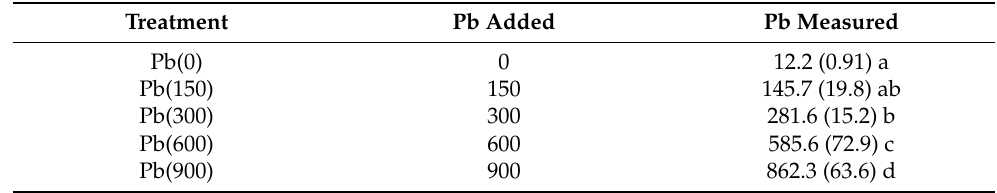
Table 1. Added and measured Pb with aqua regia (pseudo-total) (units in mg Pb kg − 1 soil). Standard deviations of measured Pb are shown in